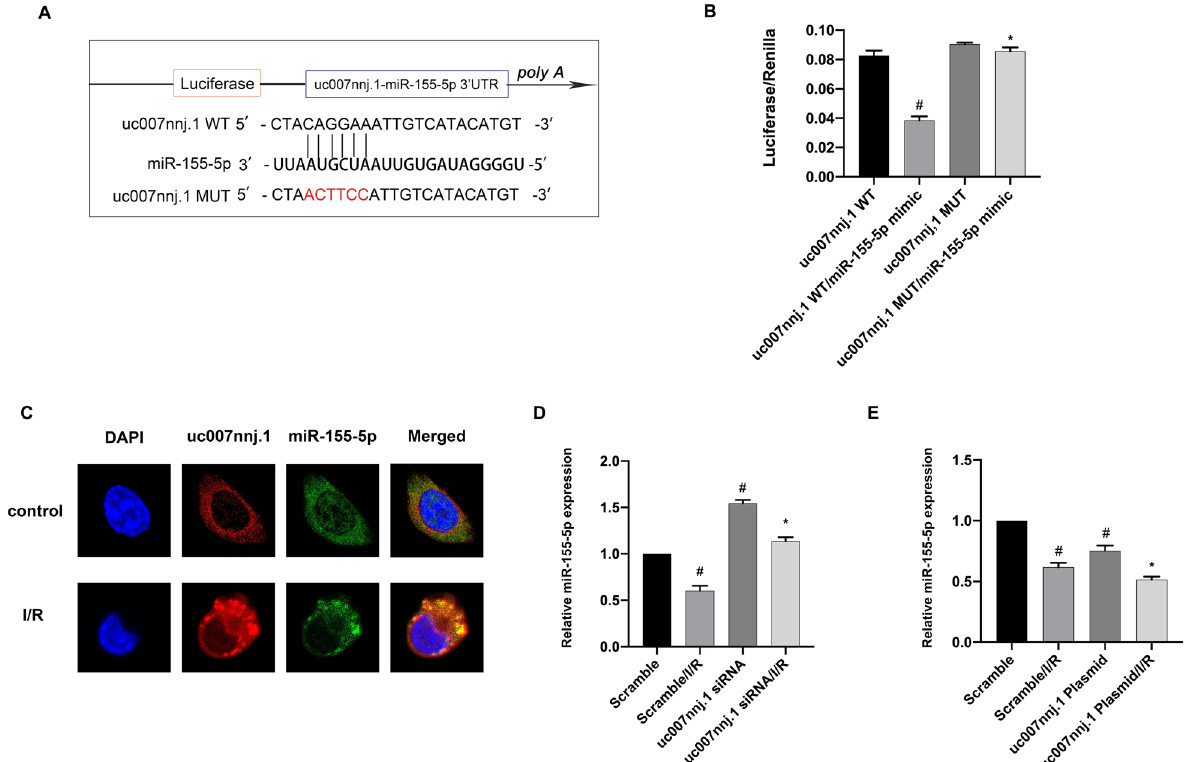
Fig. 4 lncRNA uc007nnj.1 mediates ischemia-induced RGCs apoptosis by regulating miR-155-5p as a ceRNA. A An analysis of the sequence alignment revealed lncRNA uc007nnj.1 contained potential complementary binding sequences for miR-155-5p. B Luciferase activities were measured in RGCs after being co-transfected with lncRNA uc007nnj.1 WT or lncRNA uc007nnj.1 MUT with miR-155-5p mimic or scramble. C Intracellular colocalization of lncRNA uc007nnj.1 and miR-155-5p in RGCs treated with or without I/R damage. Scale bar: 10 µm. RGCs were transfected with 50 nmol/L lncRNA uc007nnj.1 siRNA or 1 g/mL lncRNA uc007nnj.1 plasmid or scramble and then treated with or without I/R damage. D , E RT-qPCR analyzed the expression of miR-155-5p. Data are expressed as mean SD (n 6). # p < 0.05, scramble with I/R group or lncRNA ± = uc007nnj.1 siRNA group or lncRNA uc007nnj.1 plasmid group versus scramble group, lncRNA uc007nnj.1 WT/miR-155-5p mimic group versus lncRNA uc007nnj.1 WT group; * p < 0.05, lncRNA uc007nnj.1 siRNA with I/R group or lncRNA uc007nnj.1 plasmid with I/R group versus scramble with I/R group, lncRNA uc007nnj.1 MUT/miR-155-5p mimic group versus lncRNA uc007nnj.1 WT/miR-155-5p mimic group